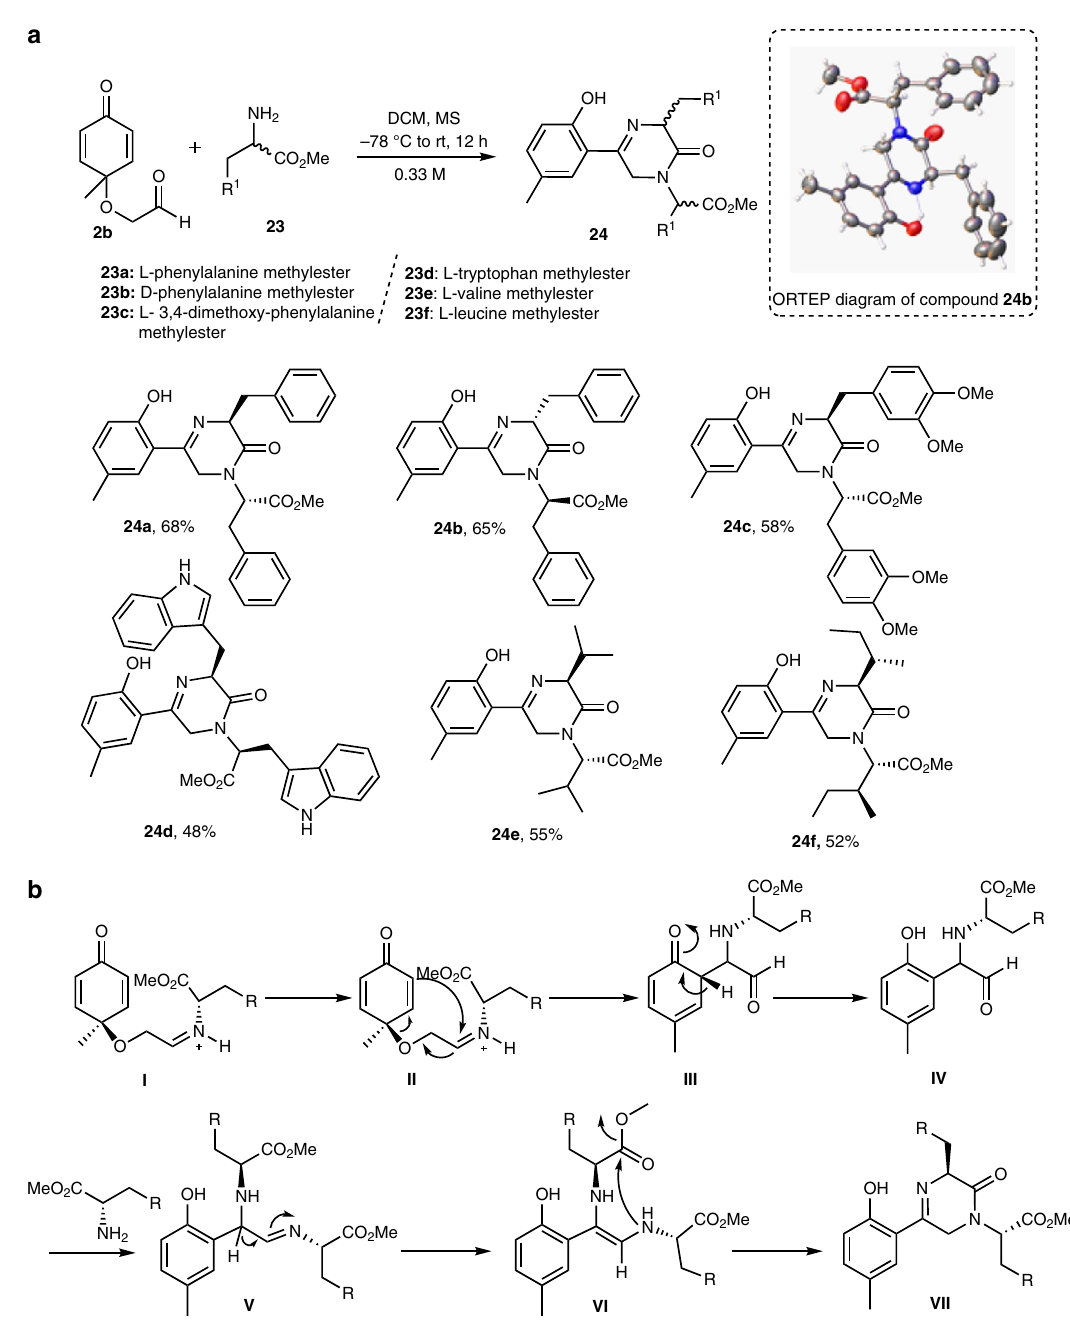
Fig. 8 Cascade transformation of quinones to piperazinones utilizing amino acids as substrates. a Asymmetric synthesis of piperazinones. b A proposed mechanism for the formation of piperazinones. MS molecular